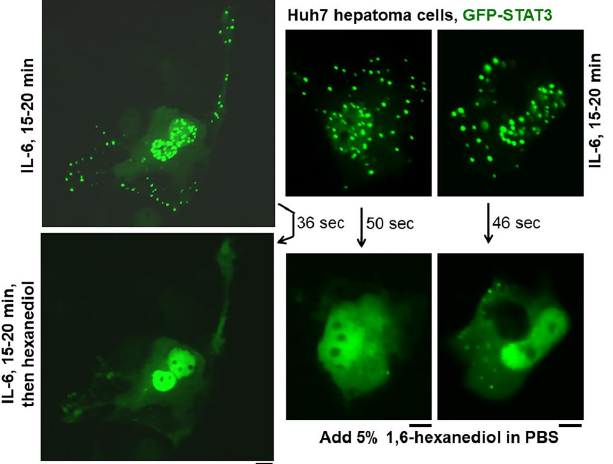
Figure 5. IL-6-induced cytoplasmic and nuclear GFP-STAT3 bodies in Huh7 hepatoma cells are phase- separated biomolecular condensates (also called “membraneless organelles” or MLOs). Huh7 cultures in 35 mm plates transfected with pGFP-STAT3 vector one day earlier were treated with IL-6 (20 ng/mL) for 15–20 min. Live cells showing IL-6-induced cytoplasmic and nuclear bodies at 15–20 min were identified, then exposed to hexanediol (5%) in phosphate-buffered saline (PBS) and imaged immediately thereafter as indicated. Figure illustrates three independent experiments. Scale bar = 25 µ m. Adapted from Sehgal, 2019